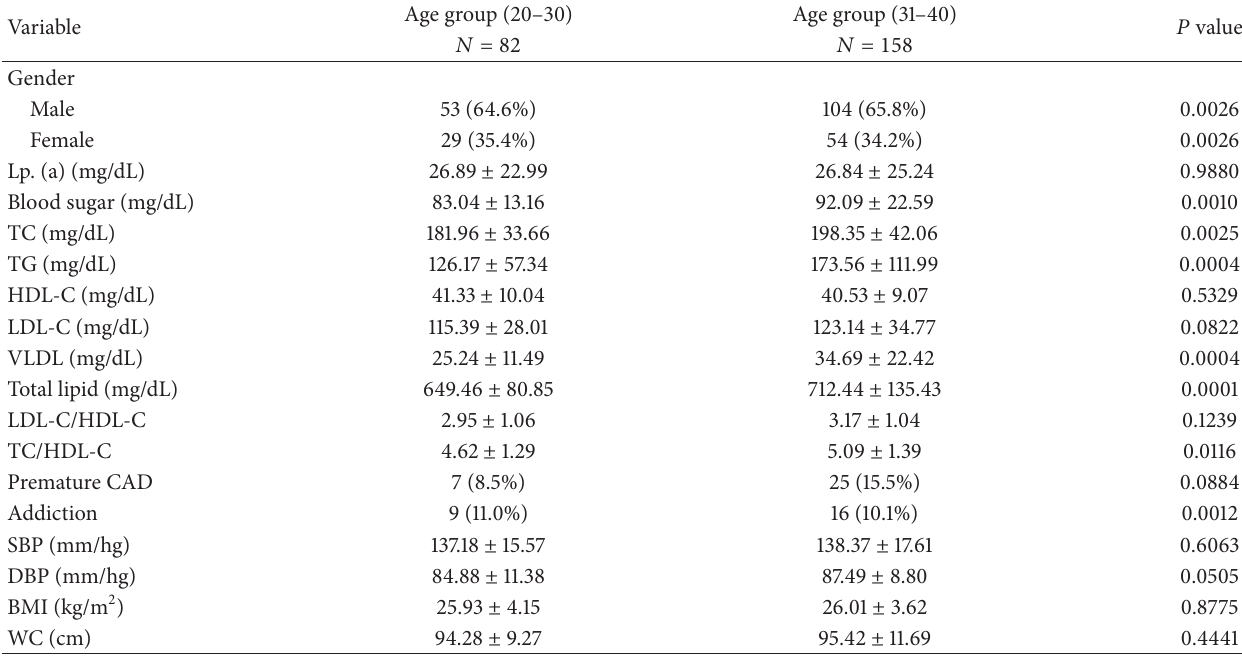
Table 4: Influence of age on prevalence and profile of metabolic